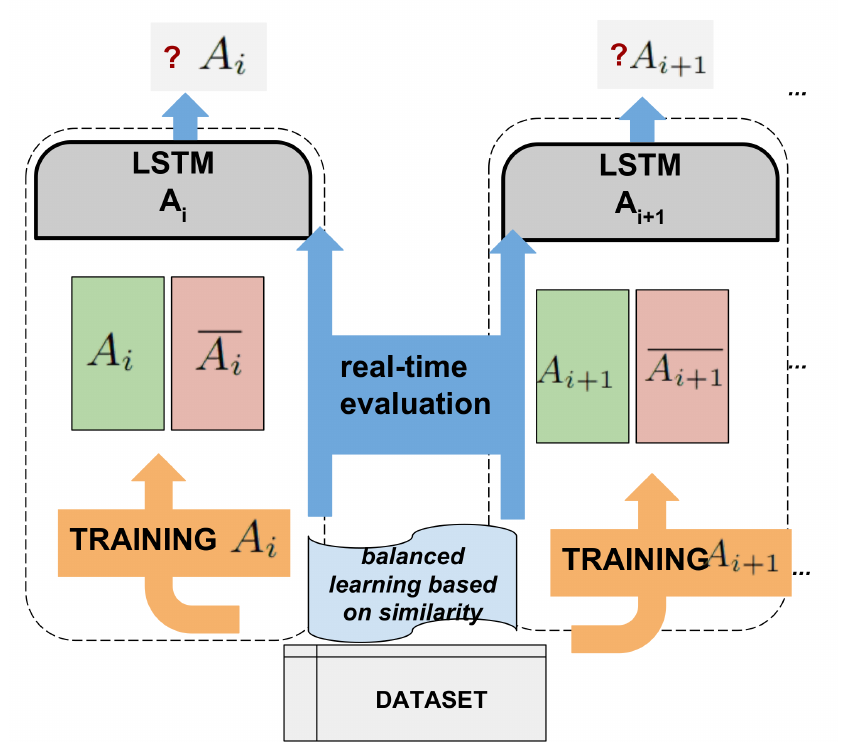
Figure 1. Scheme of ensemble of classifiers and balanced training for interleaved activity recognition. A i and A i + 1 represent different activities which can be activated in an interleaved